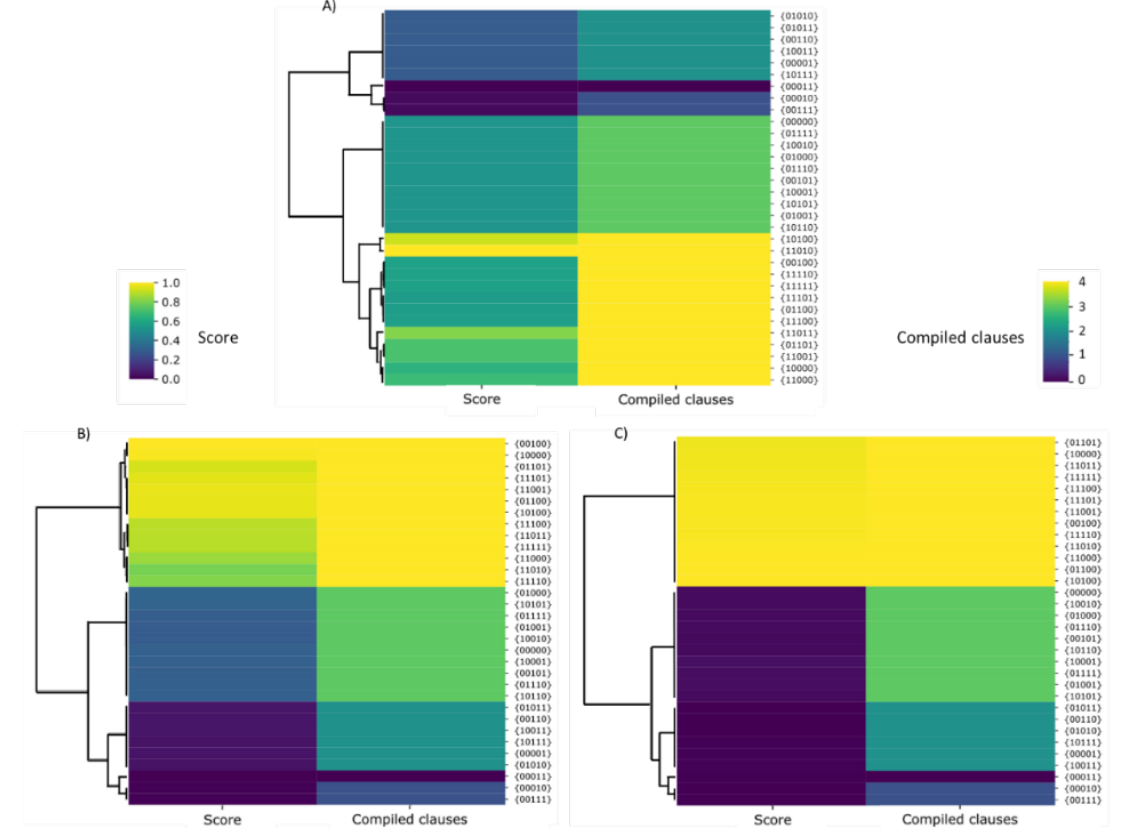
Figure 13. Spectra of solutions for the 2-SAT problem solved with the SGA, evaluating fitness with screening tools based on ( A ) the chemotaxis screening procedure, ( B ) the Lac operon screening procedure and ( C ) the antibiotic screening procedure.